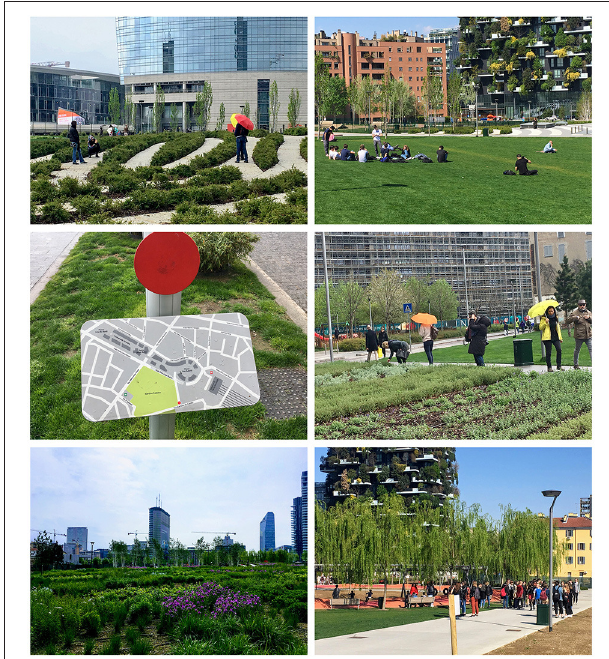
FIGURE 4 | From top left to right. People taking selfies from the photo spot where Bosco Verticale shows best in the background. People in groups relaxing on the grass. Wayfinding sign. Passers-by picking up herbs from the aromatic fields. Flowering meadow. Group of tourists visiting the area.